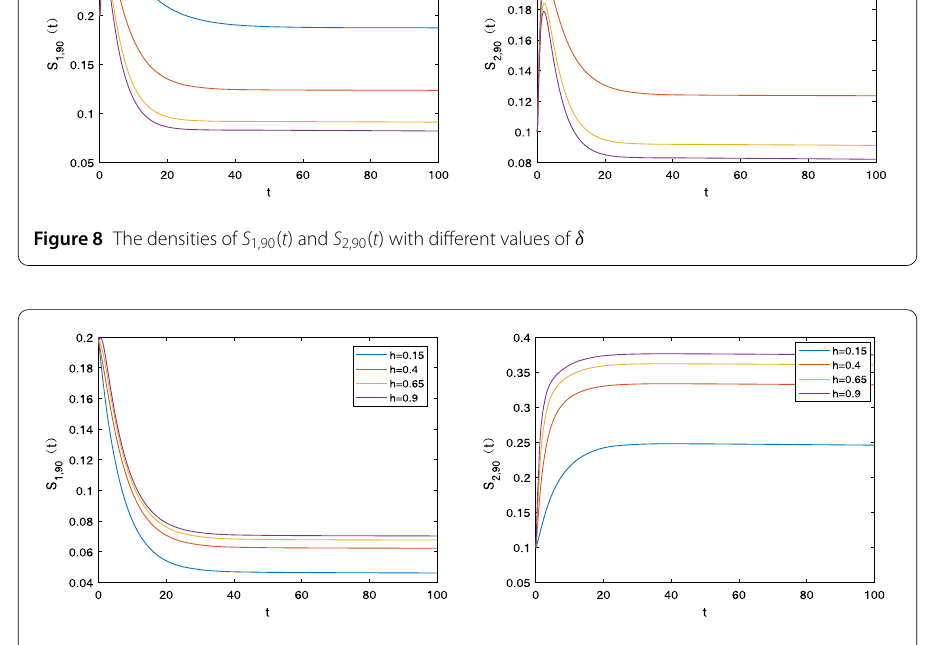
Figure 9 The densities of S 1,90 ( t ) and S 2,90 ( t ) with different values of